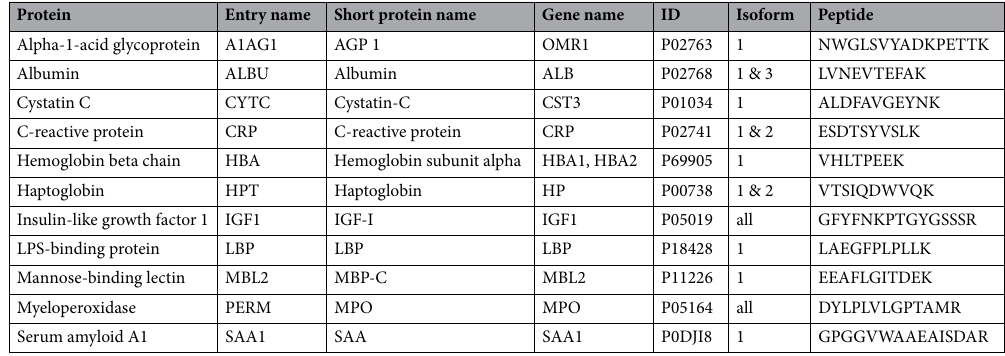
Table 2. Eleven blood proteins were measured using SISCAPA immuno-affinity enrichment mass spectrometry.